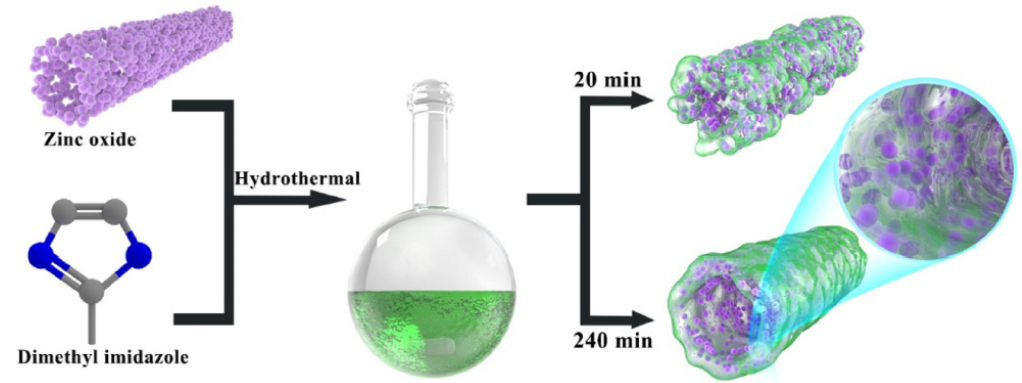
Figure 7. Synthesis process of ZIF-8 hollow nanotube. Reprinted with permission from [125], copyright 2021 Elsevier.